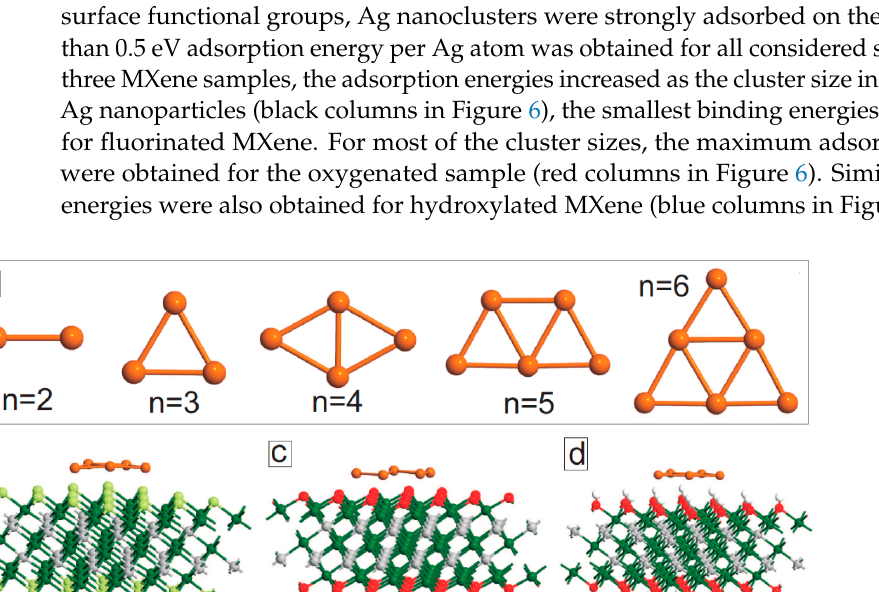
Figure 5. ( a ) Optimized structures of isolated Ag n nanoclusters. ( b – d ) Optimized structures of Ag 5 nanoparticles on Ti 3 C 2 F 2 ( b ), Ti 3 C 2 O 2 ( c ) and Ti 3 C 2 (OH) 2 ( d ).